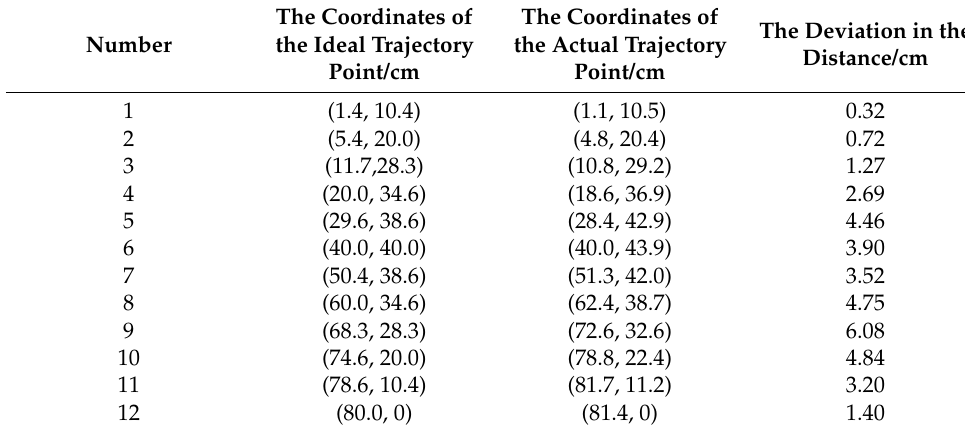
Figure 23. Experiment scene of steering in the greenhouse tomato growing area. Table 5. Experiment data of steering in the greenhouse tomato growing